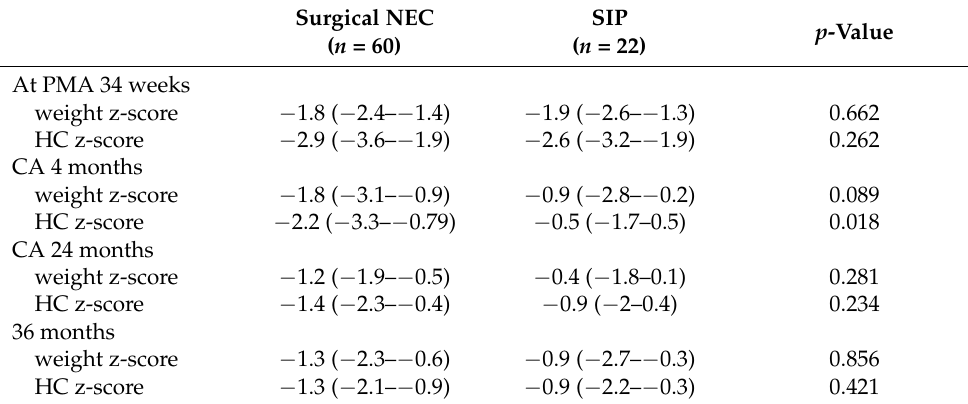
Table 2. Growth of preterm infants with surgical necrotizing enterocolitis and spontaneous intestinal perforation.